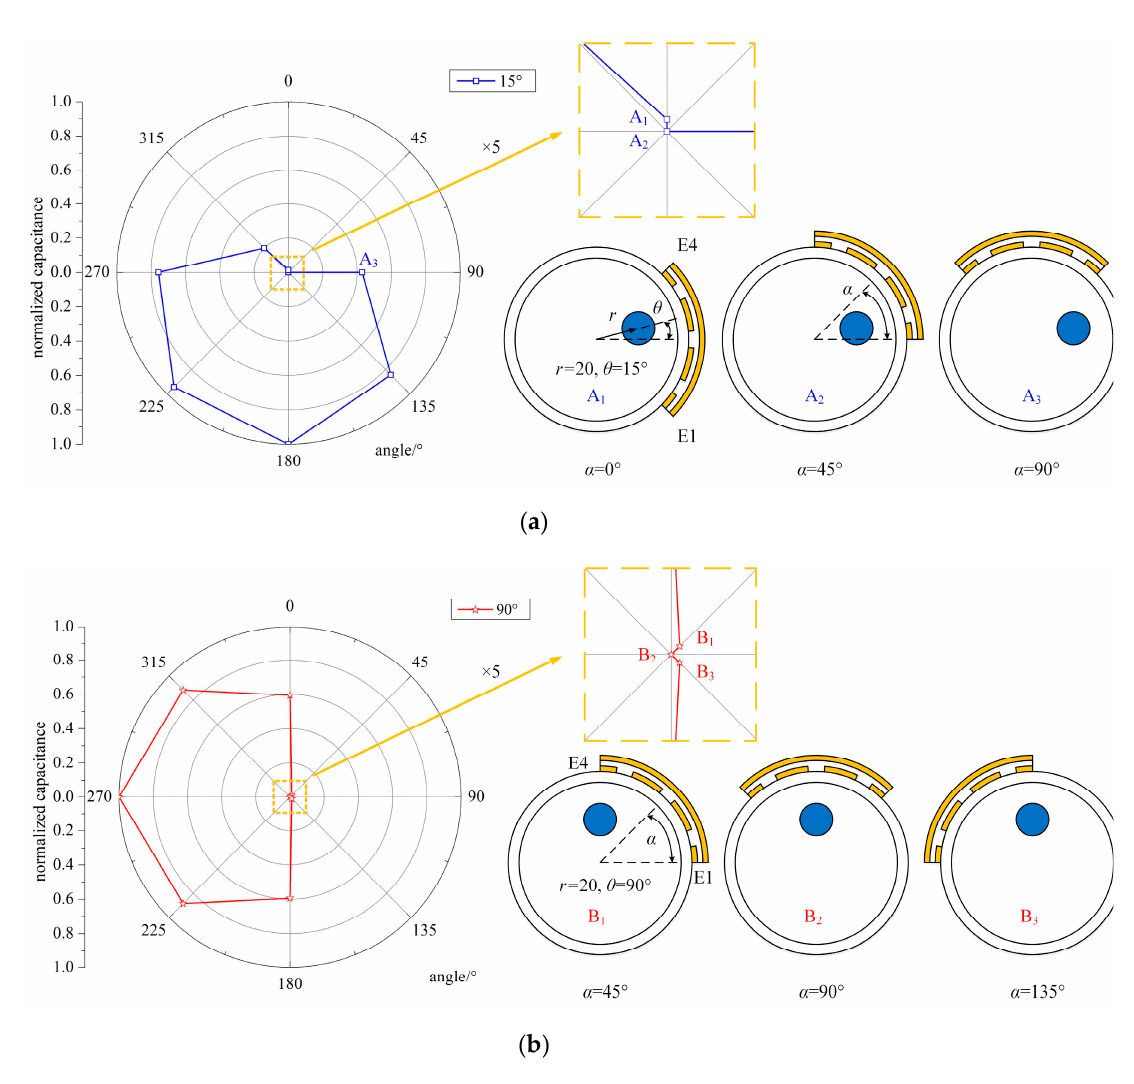
Figure 7. The normalized simulated capacitance between E1 and E4 and the special positions for θ detection. ( a ) θ = 15°, r = 20 mm, α = 0°, 45°, 90°; ( b ) θ = 90°, r = 20 mm, α = 45°, 90°, 135° .